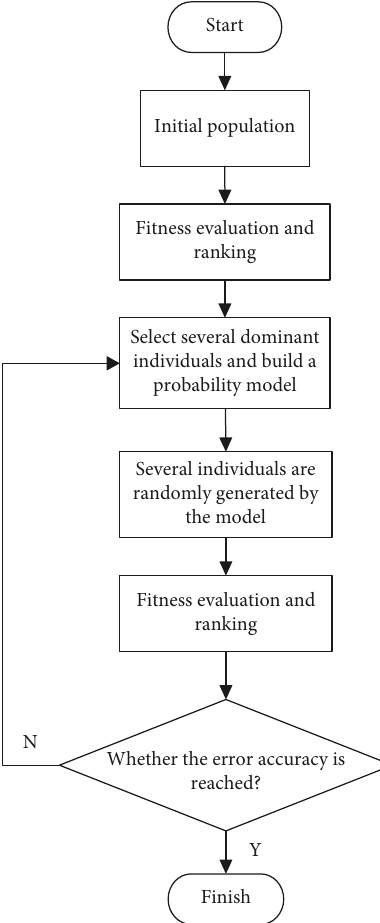
Figure 2: Flow chart of